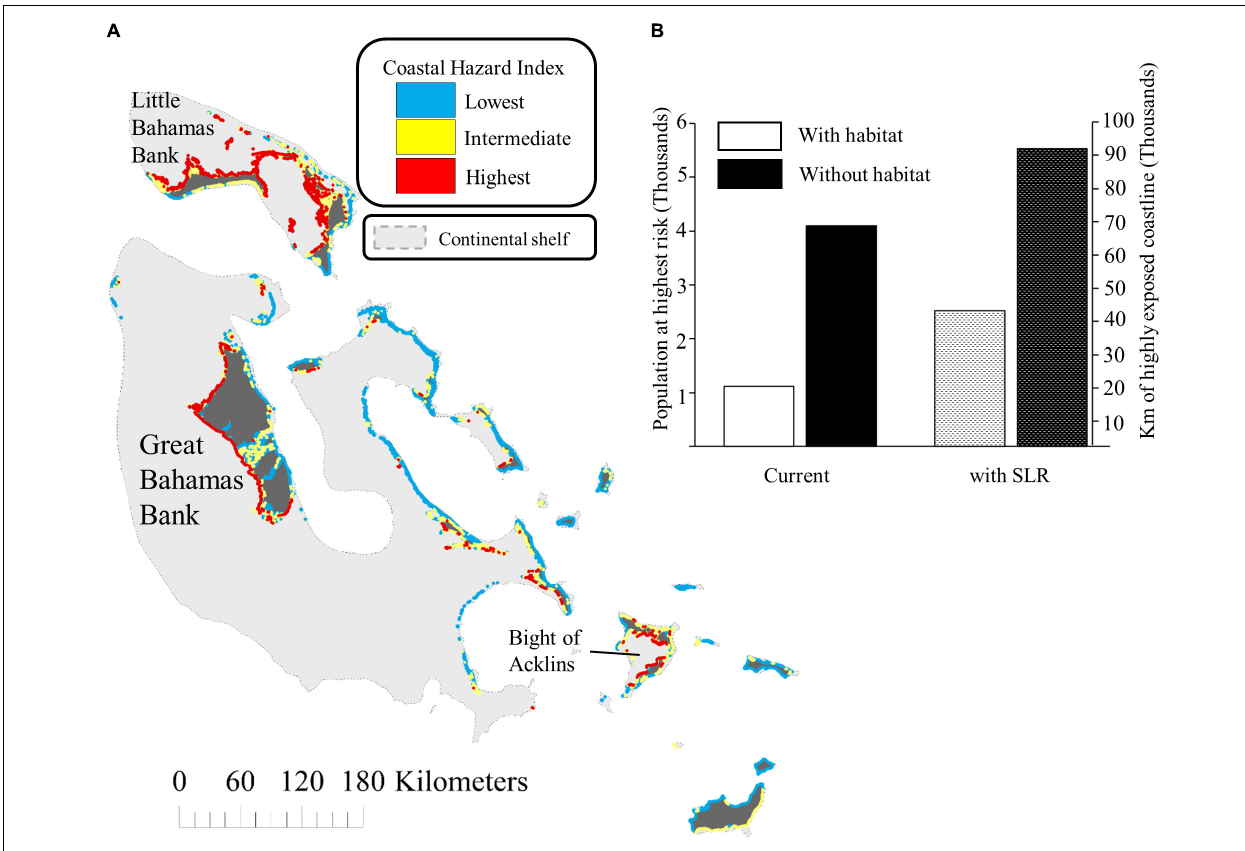
FIGURE 2 | (A) Relative exposure to coastal hazards for The Bahamas. Storm surge is a key driver of exposure for The Bahamas and this is reflected in the modeled results. The greater the distance from land to the edge of the continental shelf (in gray), the greater the potential for exposure to storm surge. (B) Length of highly exposed coastline and number of people at the highest risk with and without coastal and nearshore habitats, currently and with future SLR. Results are represented using the same set of bars for both metrics because at the national scale these variables are highly